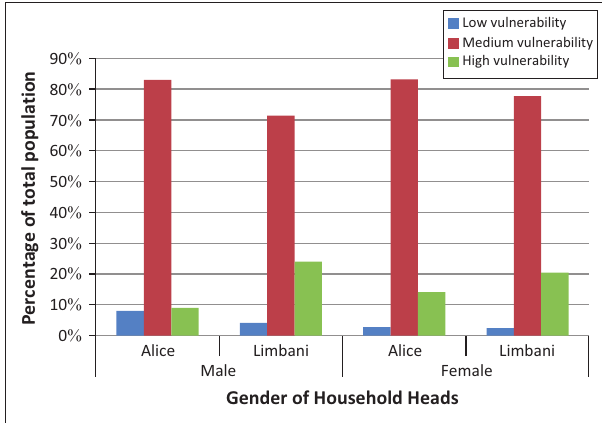
FIGURE 8: Gender dimensions of vulnerability.